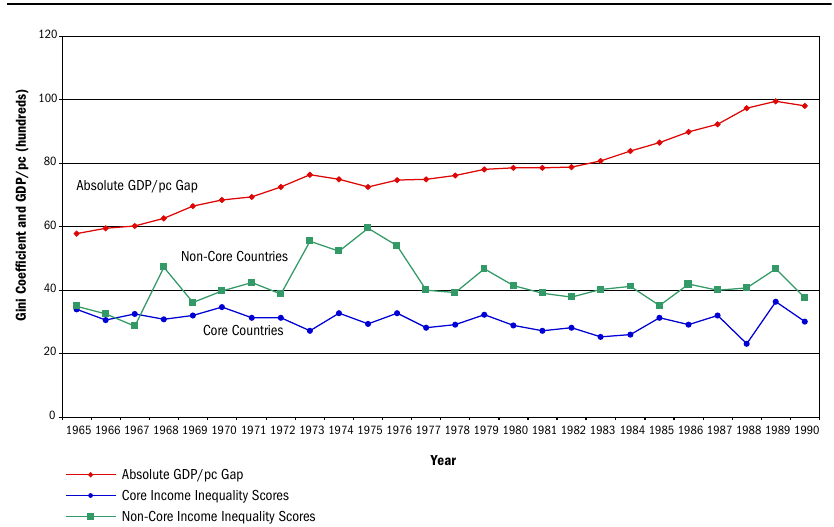
Figure 4 –The Absolute Gap versus Average Gini Index Scores for Core